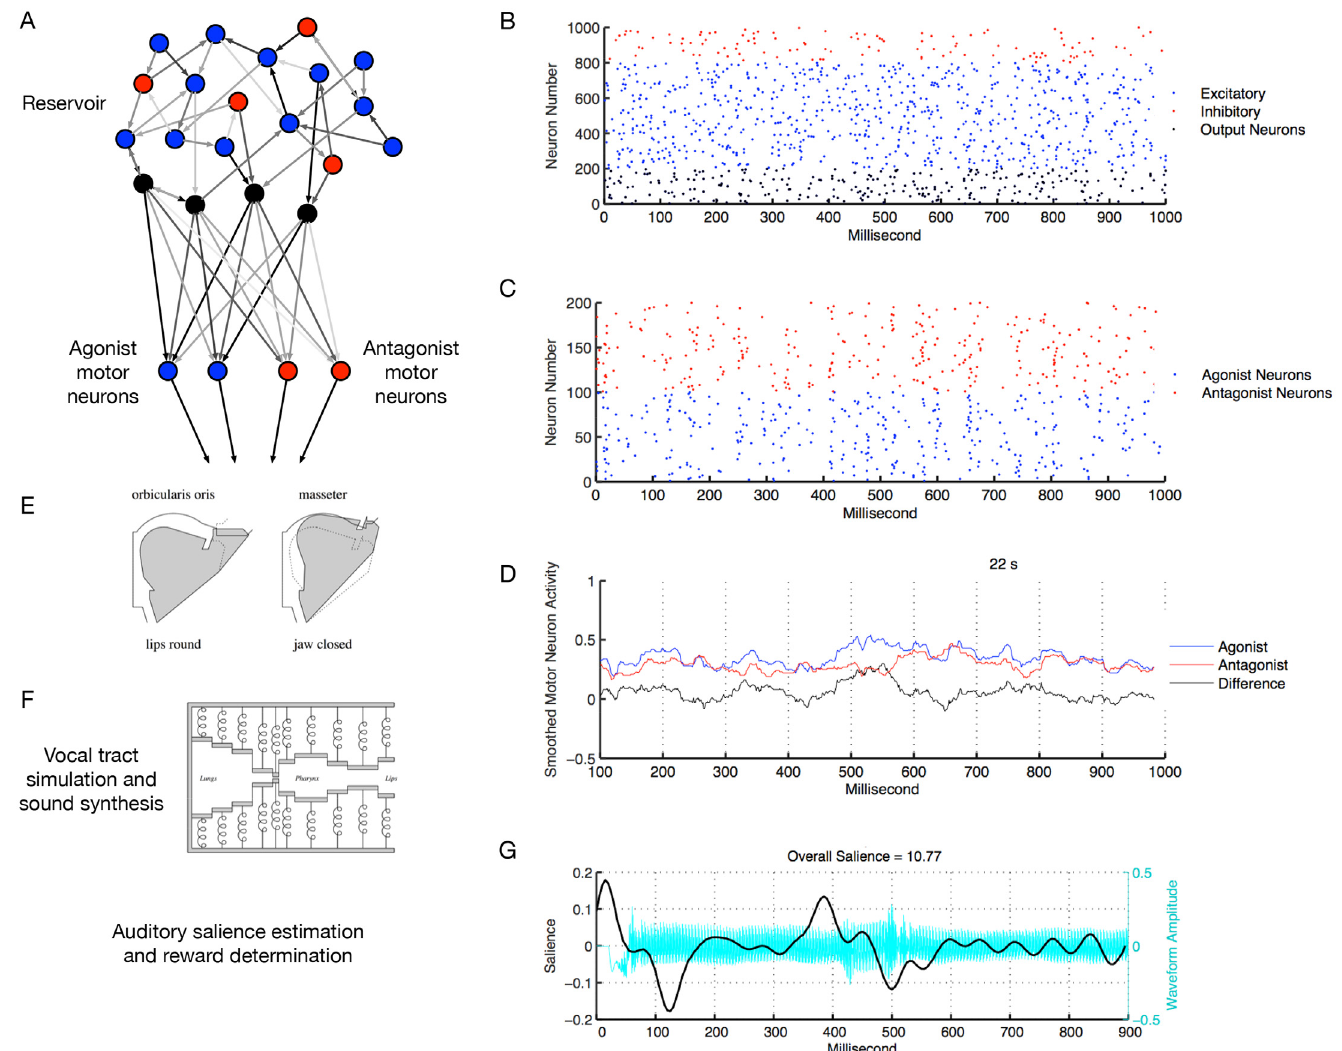
Fig 1. Overview of the model. A: Schematic depiction of the groups of neurons in the spiking neural network and how they are connected. There is a reservoir of 1000 recurrently connected neurons, with 200 of those being inhibitory (red) and the rest excitatory (blue and black). 200 of the reservoir ’ s excitatory neurons are designated as output neurons (black). These output neurons connect to two groups of motor neurons, agonist motor neurons (blue) and antagonist motor neurons (red). The connection weights within the reservoir are set at the start of the simulation to random values and do not change over the course of the simulation. The connection weights from the reservoir output neurons to the motor neurons are initially set to random values and are modified throughout the simulation by dopamine (DA)-modulated STDP. All reservoir and motor neurons receive random input current at each time step (not shown). B: Raster plot of spikes in the reservoir over a 1 s time period. C: Raster plot of spikes in the motor neuron groups over the same 1 s time period. The agonist and antagonist motor neuron spikes are summed at each time step then are smoothed using a 100 ms moving average. The smoothed antagonist activity is subtracted from the smoothed agonist activity, creating a net smoothed muscle activity that is sent to the orbicularis and masseter muscles. D: The smoothed agonist, antagonist, and net activity for the same 1 s as in the raster plots. E: Effects of the orbicularis oris and masseter on the vocal tract ’ s shape (reprinted with permission from [61]). Orbicularis oris activity tends to round and close the lips and masseter activity tends to raise the jaw. F: Schematic illustration that the vocal tract is modeled as an air-filled tube bounded by walls made up of coupled mass-spring systems (reprinted with permission from [61]). The orbicularis oris and masseter affect the equilibrium positions at the front parts of the tube. The air pressure over time and space in the tube is calculated, and the air pressure at the lip end of the tube forms the sound waveform. The vocal tract shape is modeled more realistically than depicted here and also contains a nasal cavity that is not depicted. G: The sound synthesized by the vocal tract model is input to an algorithm that estimates auditory salience. The plot shows, for the same 1 s as in B – D, the synthesized vocalization waveform (in cyan) and the salience of that waveform over time (in black). Apart from a peak in salience at the sound ’ s onset, the most salient portion of the sound is around the place where the sound ’ s one consonant can be heard. The overall salience of this particular sound is 10.77. If the salience of the sound is above the model ’ s current threshold, a reward is given, which causes an increase in dopamine concentration in the neural